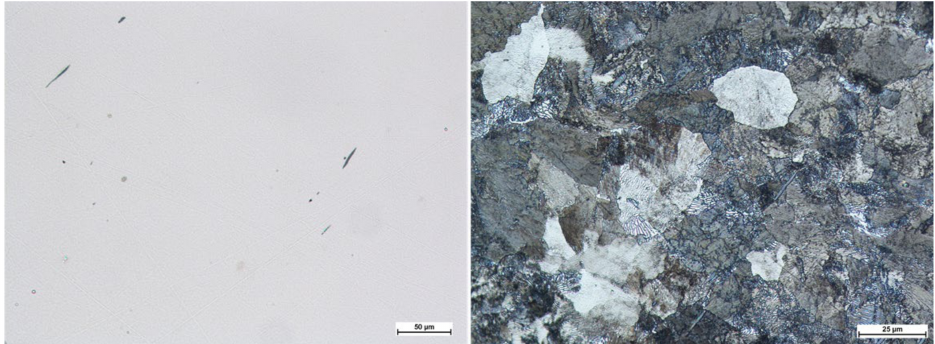
Figure 1. Microstructure of tested steel; non-etched state (on the left ) with noticeable small non- metallic inclusions and pearlite structure (on the right ) after etching 3% HNO 3 .